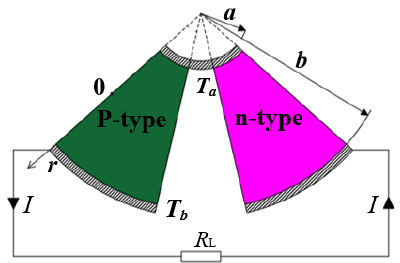
Figure 1. Basic model of ATEG.